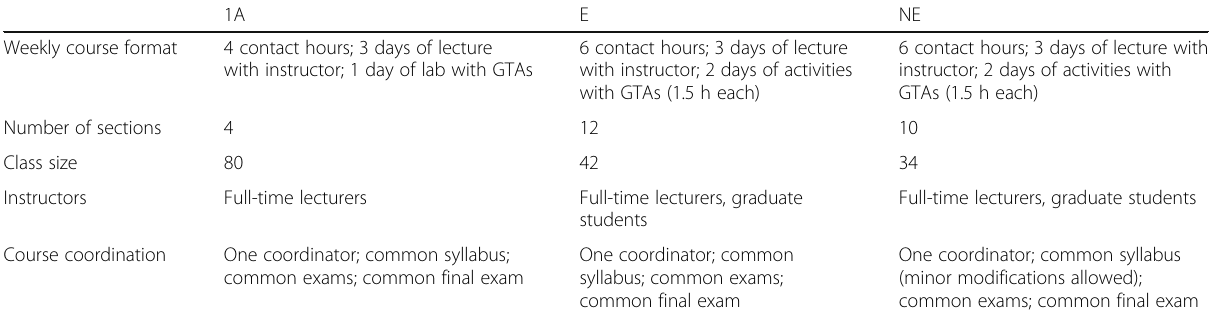
Table 1 Calculus I course formats